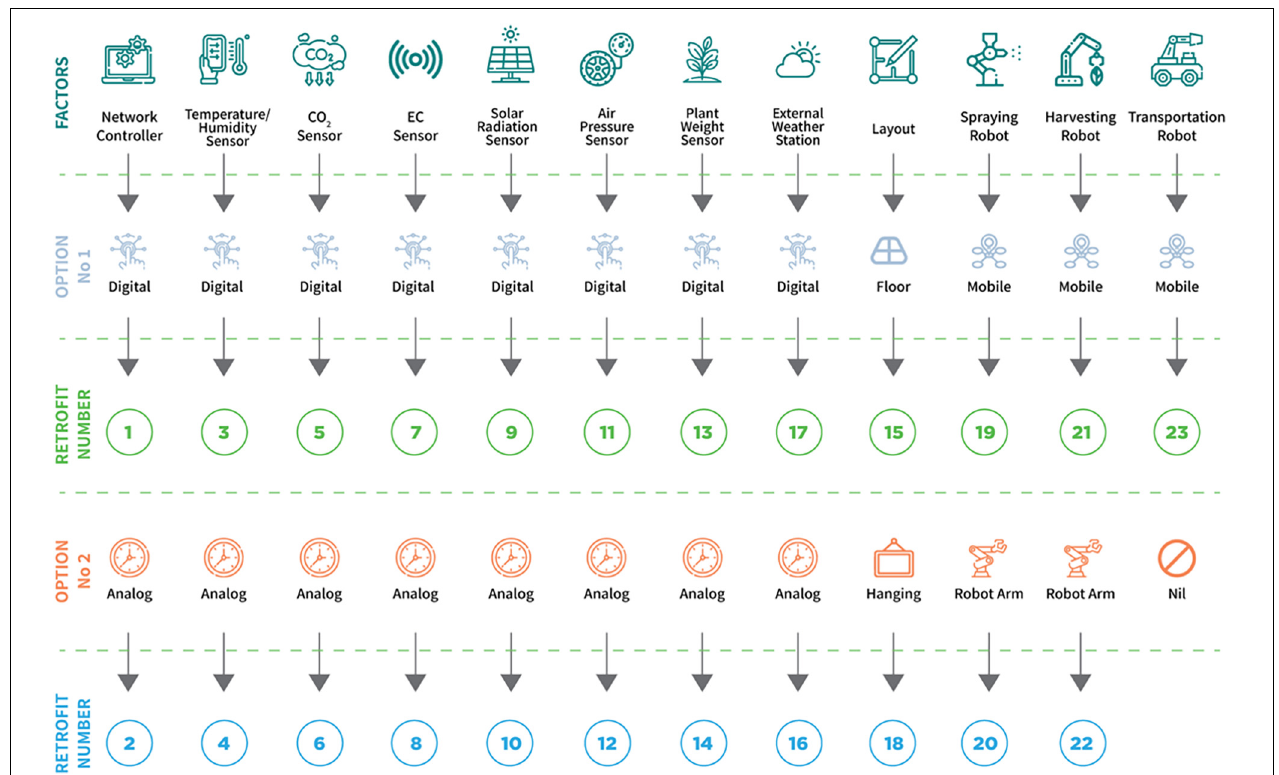
FIGURE 1 | Retrofit factors and options used in the experimental simulation.